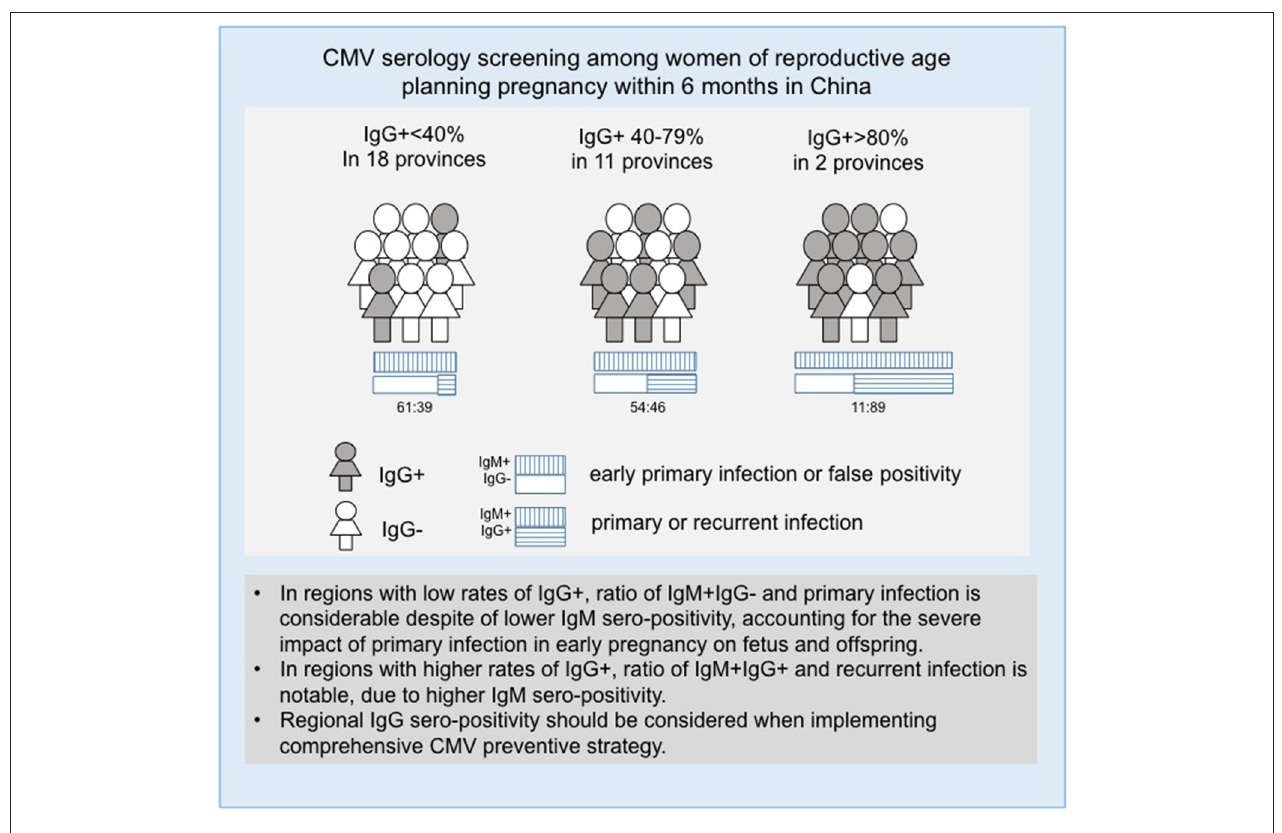
FIGURE 3 | Diagram of CMV serology before pregnancy in